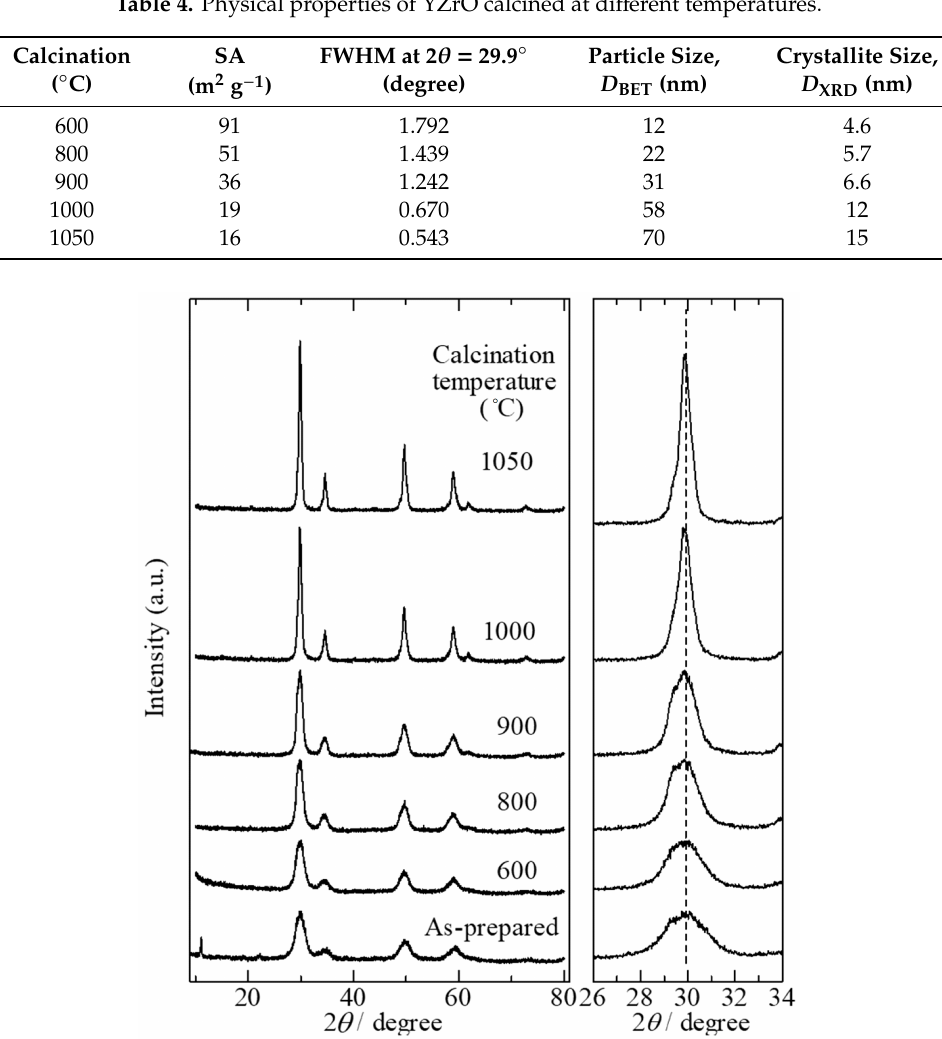
Figure 3. Continuous scanning XRD patterns of